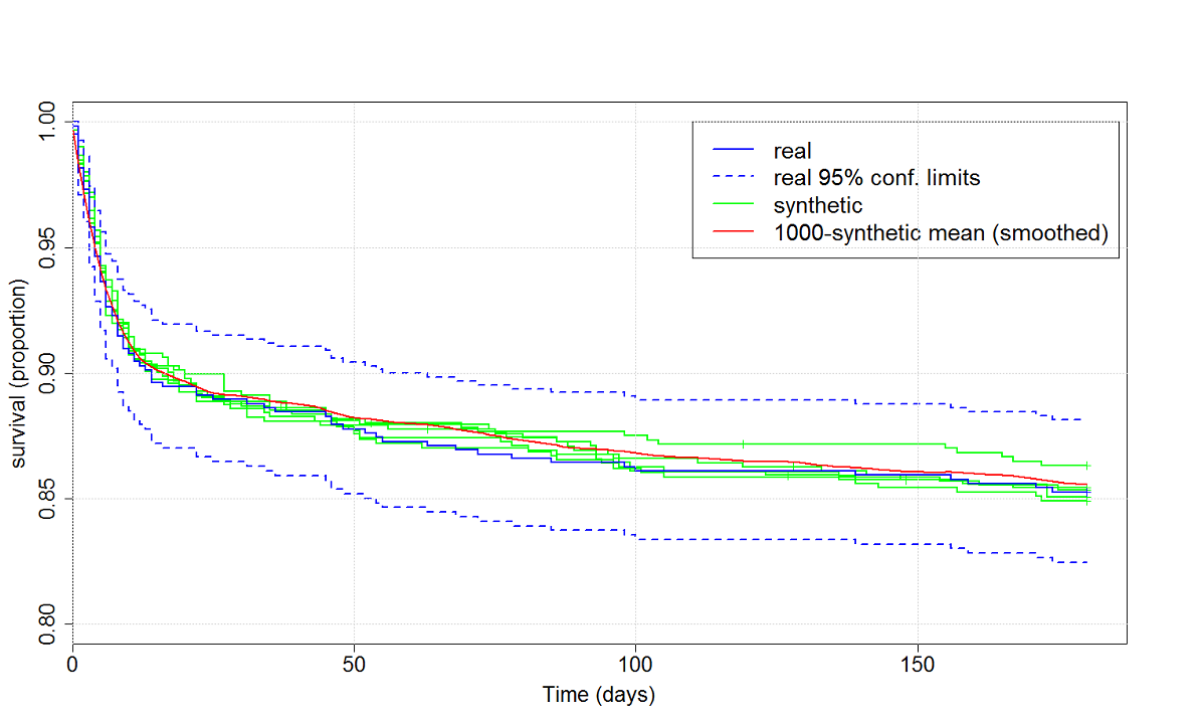
Figure 2. Kaplan-Meier 180-day event-free (CHF/mortality) survival curves after primary PCI, estimated from the real data with 95% confidence limits (blue) and from five repeatedly generated synthetic datasets (green). Survival curves based on synthetic data were similar to curves based on real data, and the mean curve based on 1000 synthetic sets was similar to the curve obtained from the real data.